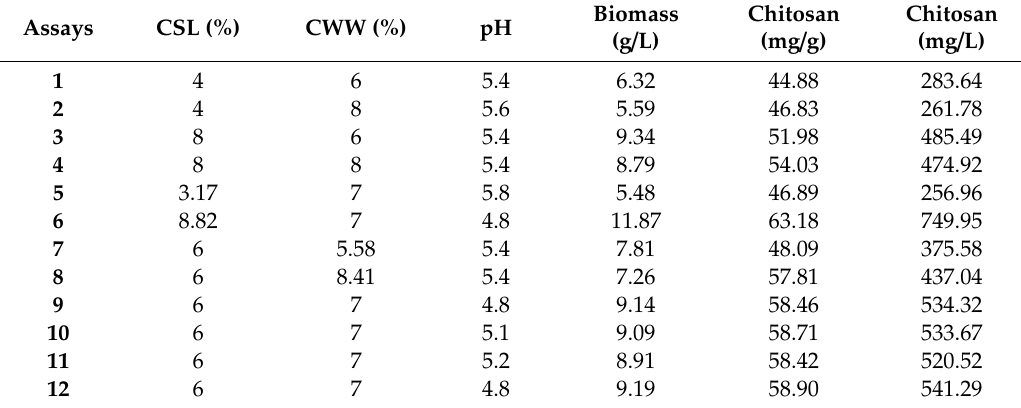
Table 6. Central composite rotatable design applied to the production of biomass and chitosan by L. hyalospora (UCP 1266) using CSL and CWW as alternatives